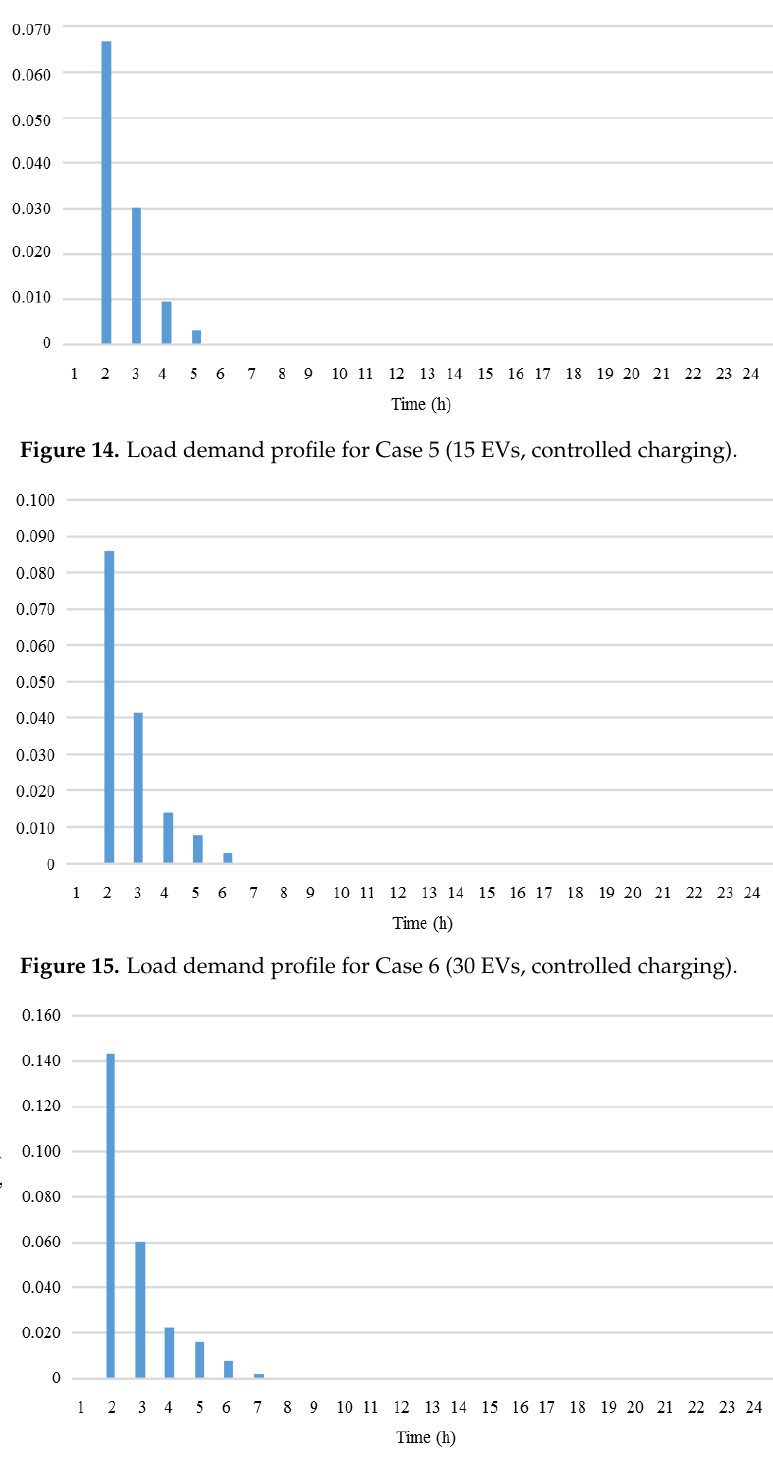
Figure 16. Load demand profile for Case 7 (50 EVs, controlled charging).